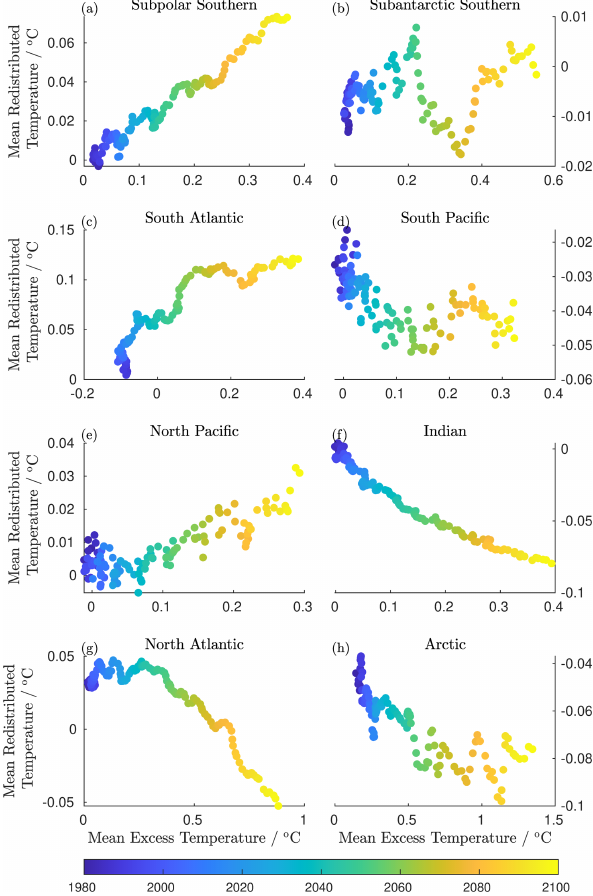
Figure 7. The emergent relationships (if any) observed between ex- cess and redistributed heat in each of the eight ocean basins shown in Fig. 7, presented in terms of the mean redistributed and excess temperature changes for the basin. Time series begin in 1980 as there is no appreciable accumulation of excess or redistributed heat in the first half of the run. Scales differ for each